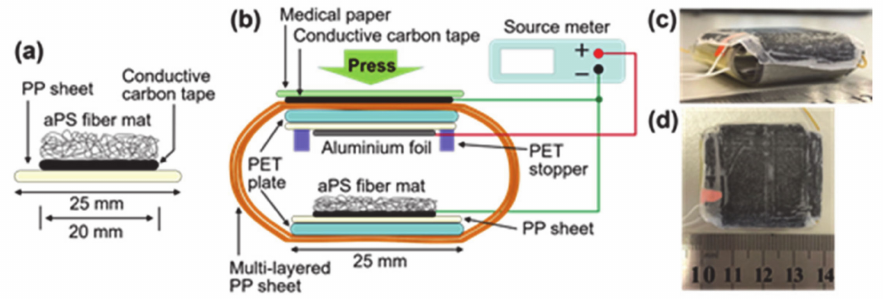
Figure 2. Schematics of ( a ) the collector sheet and ( b ) developed pressure sensor. Photographs of the sensor: ( c ) side-view and ( d ) top